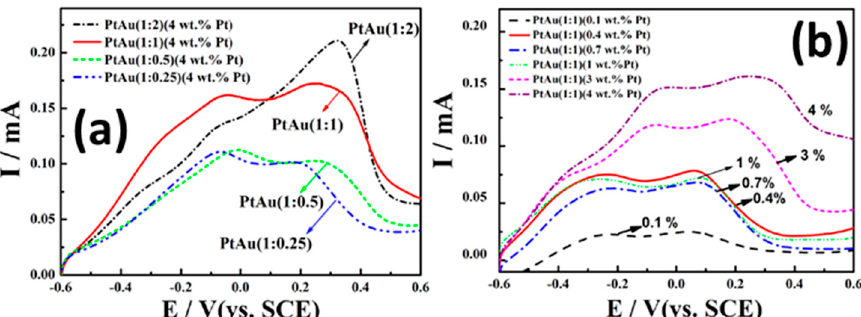
Figure 13. ( a ) LSV measurements for the PtAu (1: x )/C electrodes with different Pt:Au ratios (i.e., x = 2, 1, 0.5, and 0.25) recorded in the 0.08 M NaOH containing 10 mM glucose. ( b ) LSV measurements for the PtAu (1:1)/C with different metal loading in 0.08 M NaOH containing 10 mM glucose. (Reproduced with permission from [229]. Copyright Elsevier, 2020).